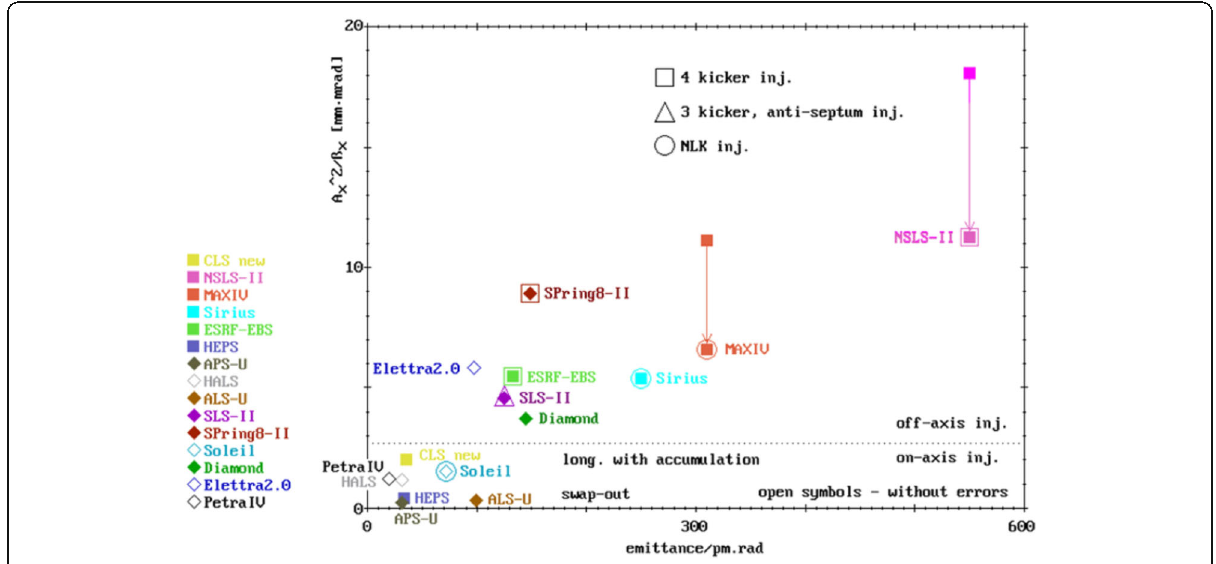
Fig. 17 Transverse dynamic acceptance along emittance